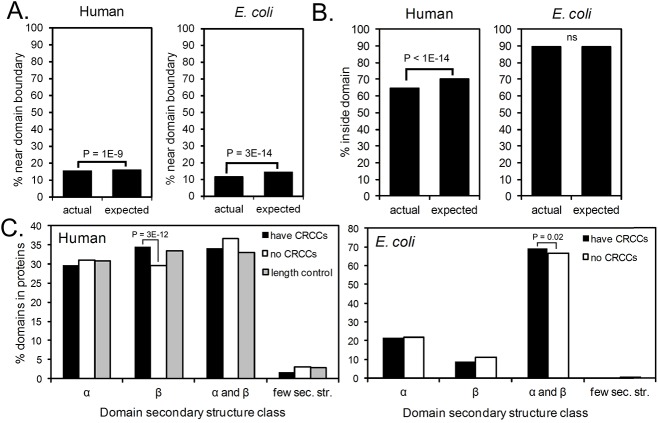
Positions of CRCCs relative to protein domains.(A) Comparison of the actual and expected frequency of CRCCs near (within +/- 20 codon positions) of domain boundaries. Expected frequency is based on random distribution, and p-values are calculated using a binomial test. (B) The majority of CRCCs in human and E. coli are found within mRNA regions encoding conserved structural domains. (C) Secondary structure classes of CATH domains in human and E. coli ORFeomes. CATH domains annotated by Gene3D were divided by secondary structure class. Graphs indicate the percent of domains that belong to each secondary structure class, for proteins in homolog families with (black) or without (white) conserved rare codon clusters (CRCC) (co-occurrence p-value ≤ 1E-4 after termini and RRT screening). Although human proteins from homolog families with CRCCs are significantly over-enriched in β-sheet-rich domains, this enrichment is most likely due to the longer average length of proteins with CRCCs, as similar results were seen for a control set of proteins with similar length but no CRCCs (gray).